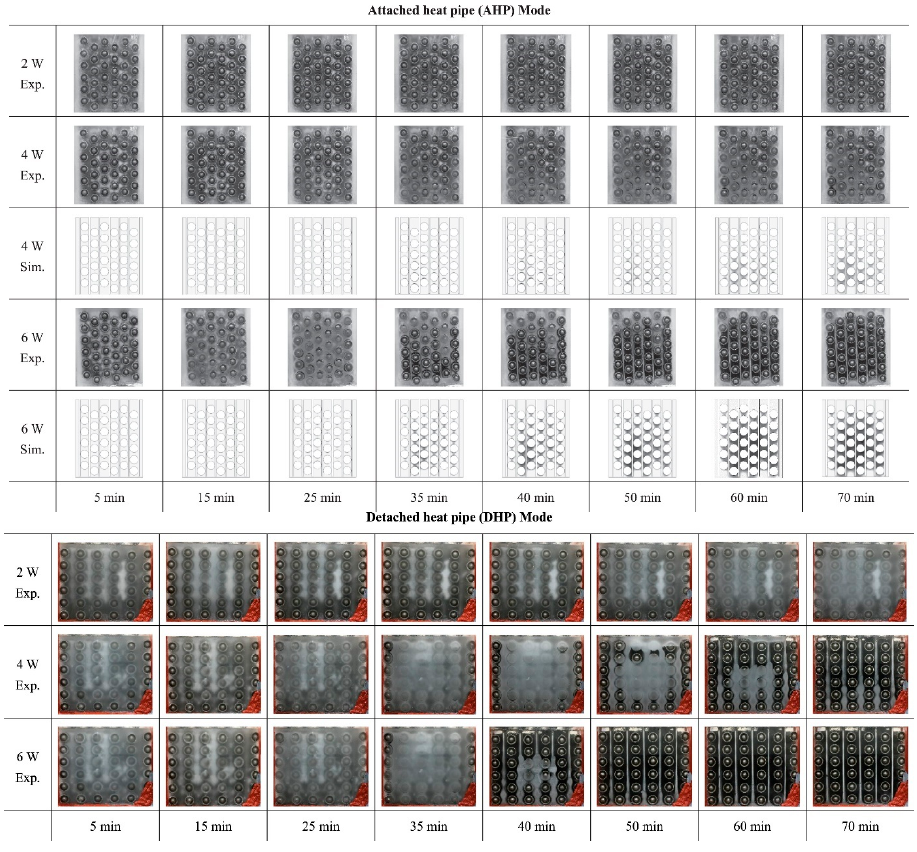
Figure 30. Experiment (visualization) and simulation ( top ) for the AHP system; Experiment (visualization) for the DHP system ( bottom ) [105]. Reproduced with permission from Elsevier.